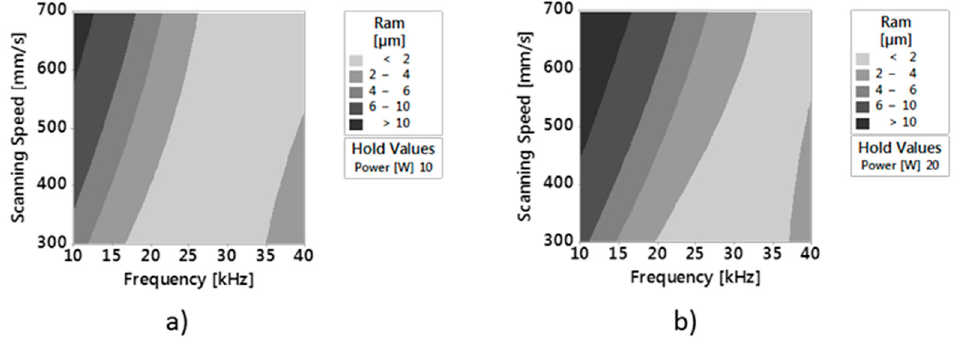
Figure 11. ( a ) Contour Plot of Ram versus v and F p at constant P of respectively 10 W and ( b ) 20 W.